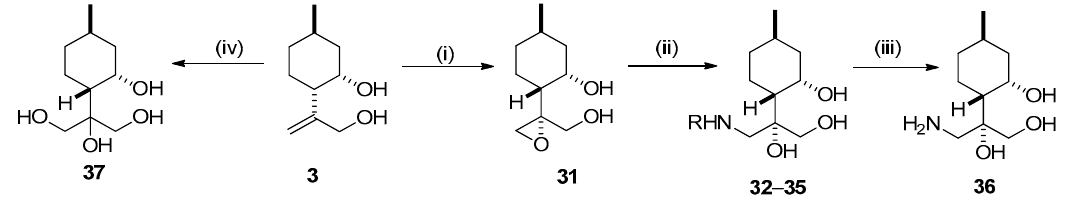
Figure 4. Determination of the structure of epoxide 31 by